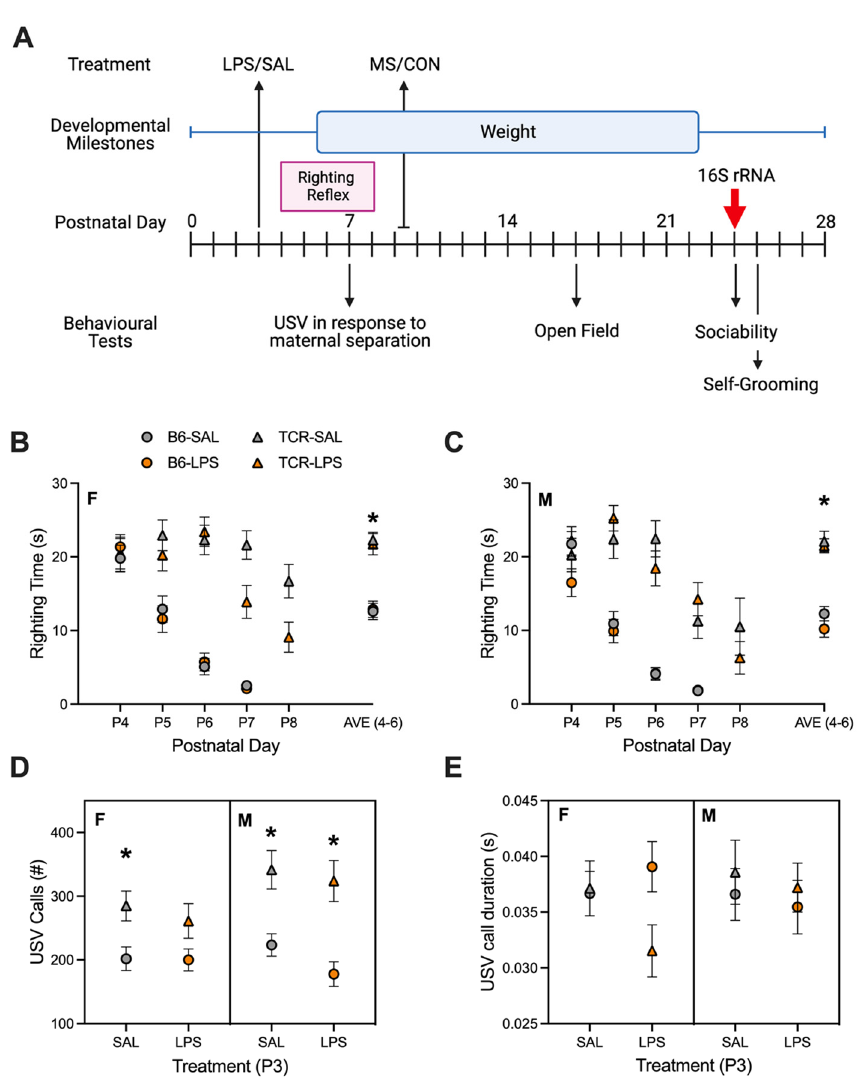
Figure 1. Postnatal behaviour differed in T-cell deficient mice. ( A ) Experimental design showing postnatal challenges, developmental outcomes, and behavioural tests used in the first 4 weeks of postnatal life. Red arrow indicates date of fecal sample collection for 16S rRNA sequencing analysis for microbiota. ( B ) Daily righting reflex time and P4–6 average time (s) for female mice. ( C ) Daily righting reflex time and P4–6 average time (s) for male mice. ( D ) Number of USV calls during 3 min separation from dam for male and female mice. ( E ) Average USV call duration during 3 min separation from dam from male and female mice. * p < 0.05, mean ± S.E. provided. Panel A was created using